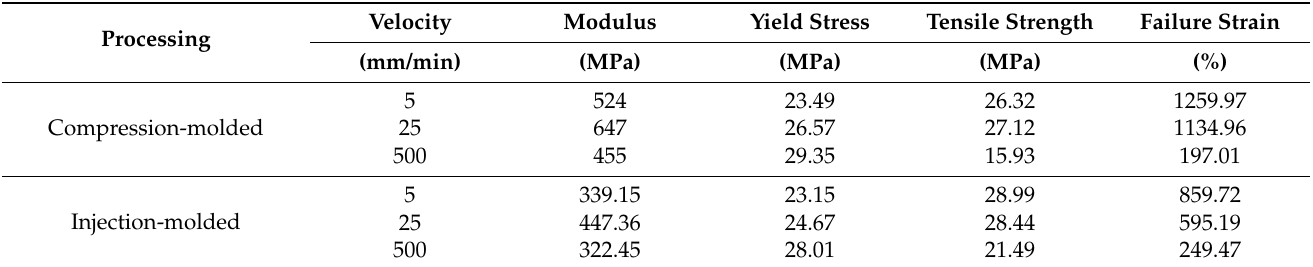
Table 1. Compression-molded and injection-molded sample mechanical